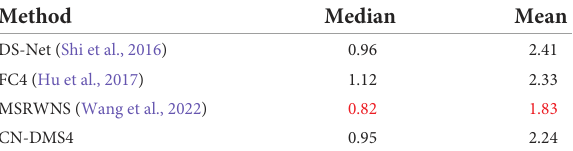
TABLE 5 Quantitative evaluation on SFU Gray-Ball (Ciurea and Funt, 2003), red indicates the best.